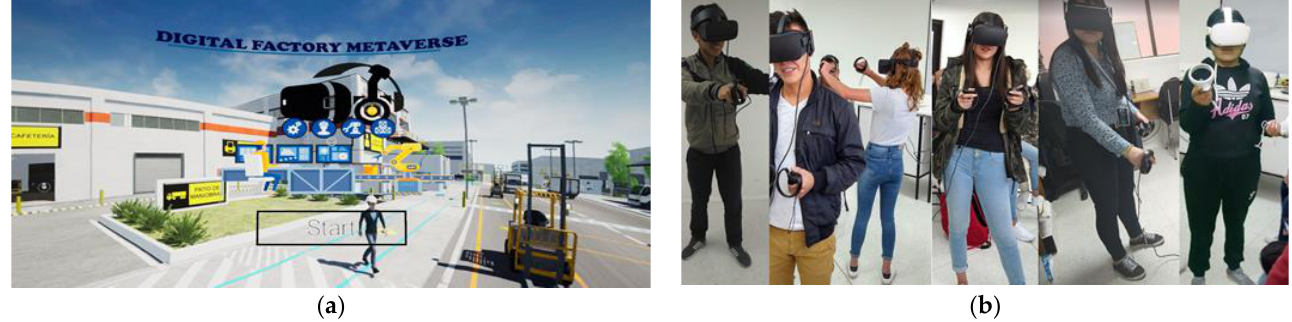
Figure 7. VR testing functionality and playability. ( a ) digital factory metaverse app home screen; and ( b ) users testing the application with VR in laboratory.